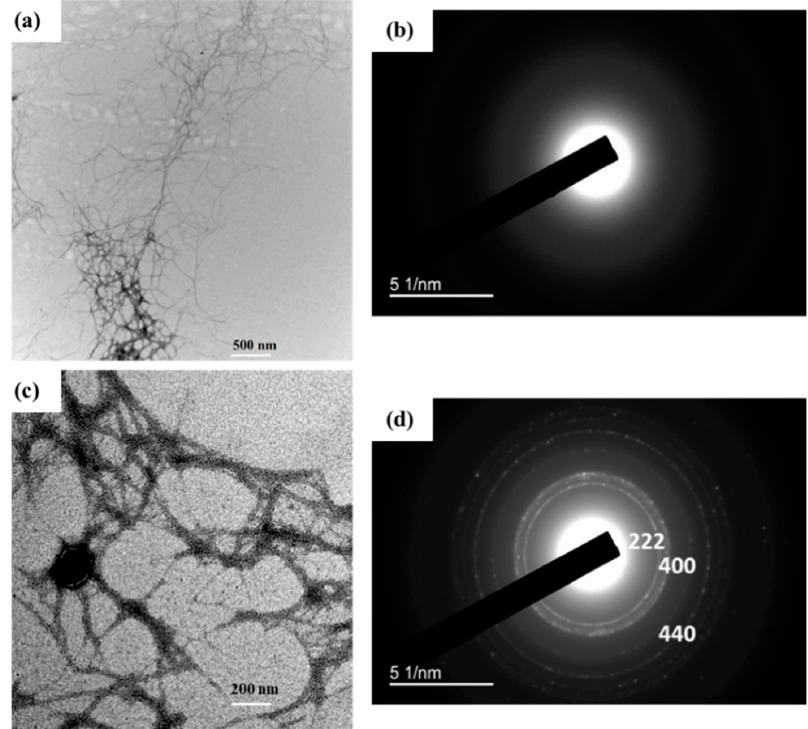
Figure 6. TEM and electron diffraction (ED) of ( a , b ) NOCNF (0.32 wt%)); ( c , d ) TEM and ED of NOCNF-Tl floc (0.32 wt% NOCNF with 300 ppm Tl(I)).